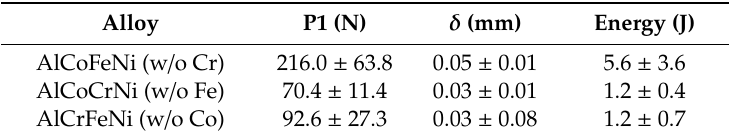
Table 3. Mean values of the forces, displacement ( δ ), and energy, as extracted from the SPT curves of the studied